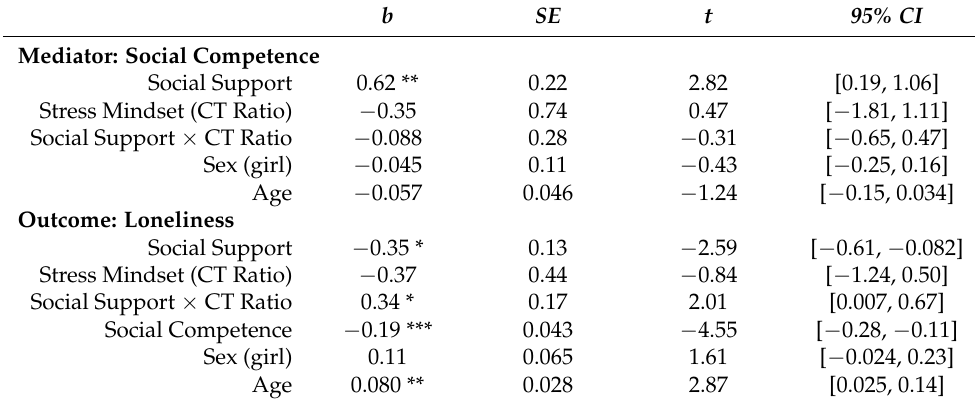
Table 2. Results of the moderated mediation model.